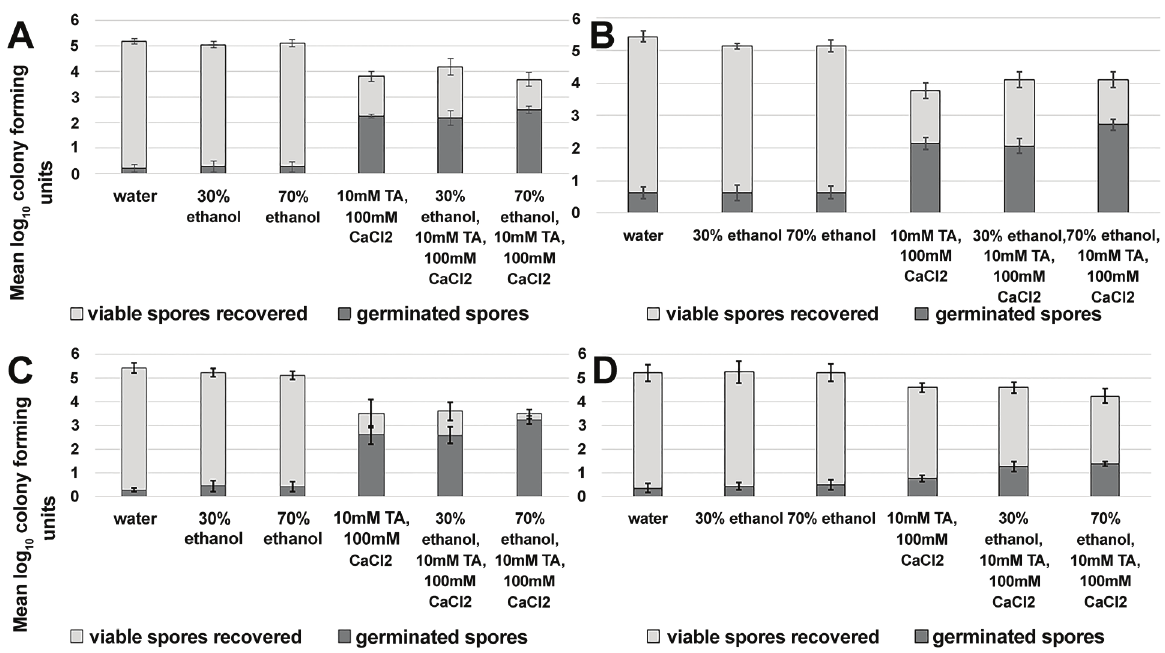
Figure 3. Exposure to germinants reduces recovery of viable Clostridium difficile spores on environ- mental surfaces. Stainless steel carriers (1 cm 2 ) were placed on a hospital bedside table and inoculated with 6 log colony forming units (CFU) of C. difficile R20291 (A), VA17 (B), ATCC 43598 (C), and VA11 10 (D). Carriers were sprayed until uniformly wet with test solutions and allowed to air dry. After 24 hours of incubation at room temperature, the spores were recovered from carriers and the log germinated spores was determined. The means of triplicate data from 2 experiments are presented (N = 6). Error bars indicate standard